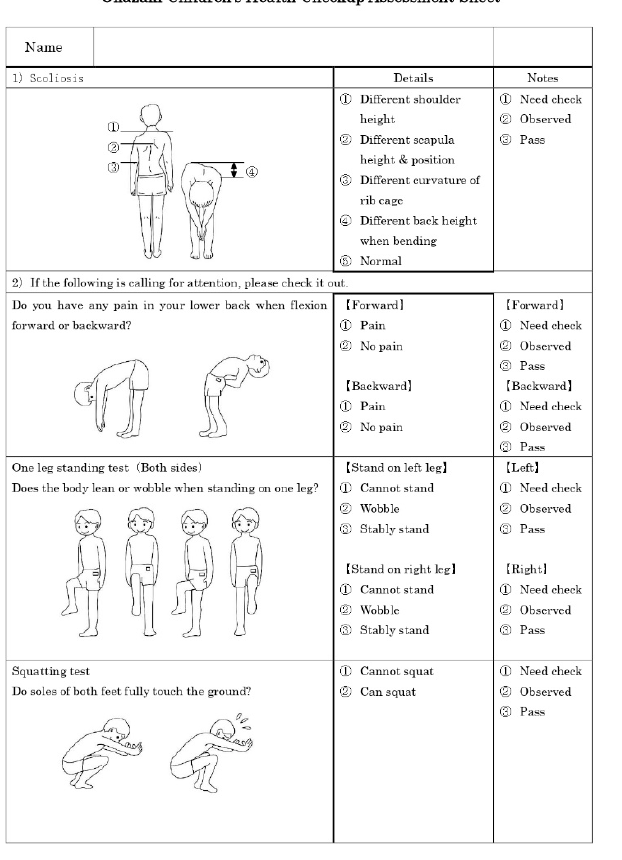
Figure 1. Okazaki Children’s Health Checkup Assessment Sheet. Participants were assessed for locomotive syndrome by using the musculoskeletal health checkup assessment sheet [4].